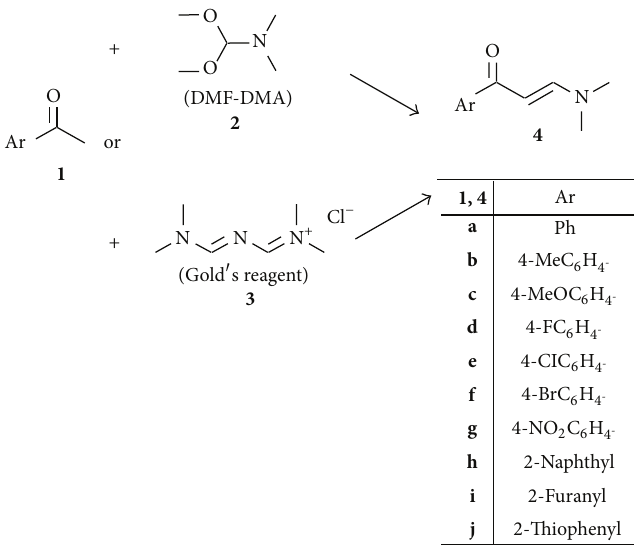
Scheme 1: Structure of compounds 1–4a–j .